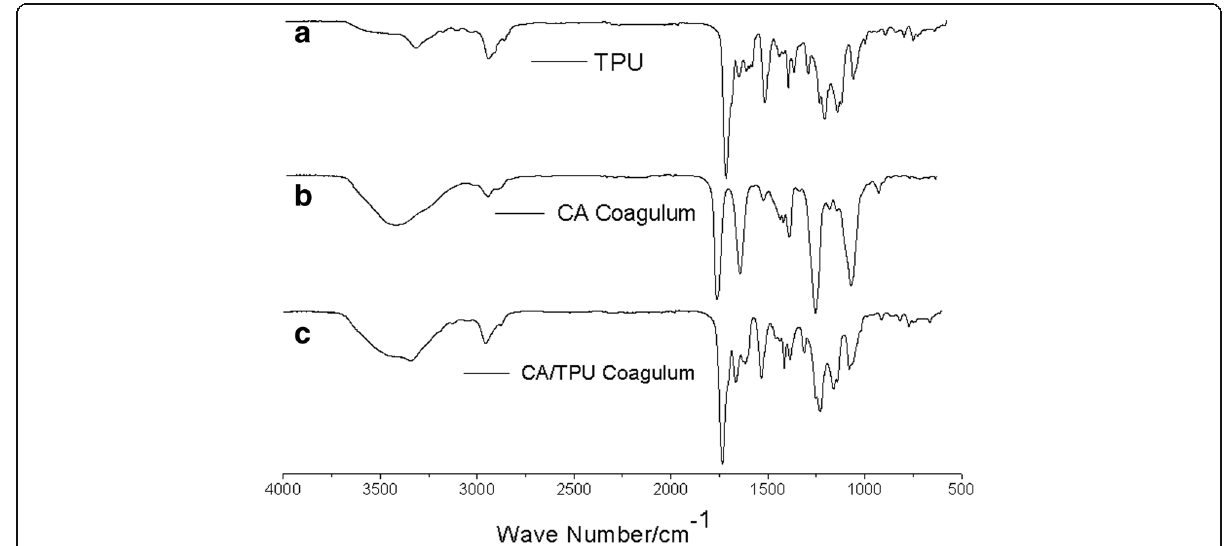
Fig. 6 FTIR of the CA/TPU component system including pure polymers and the blends: a TPU coagulum, b CA coagulum, and c CA/TPU coagulum